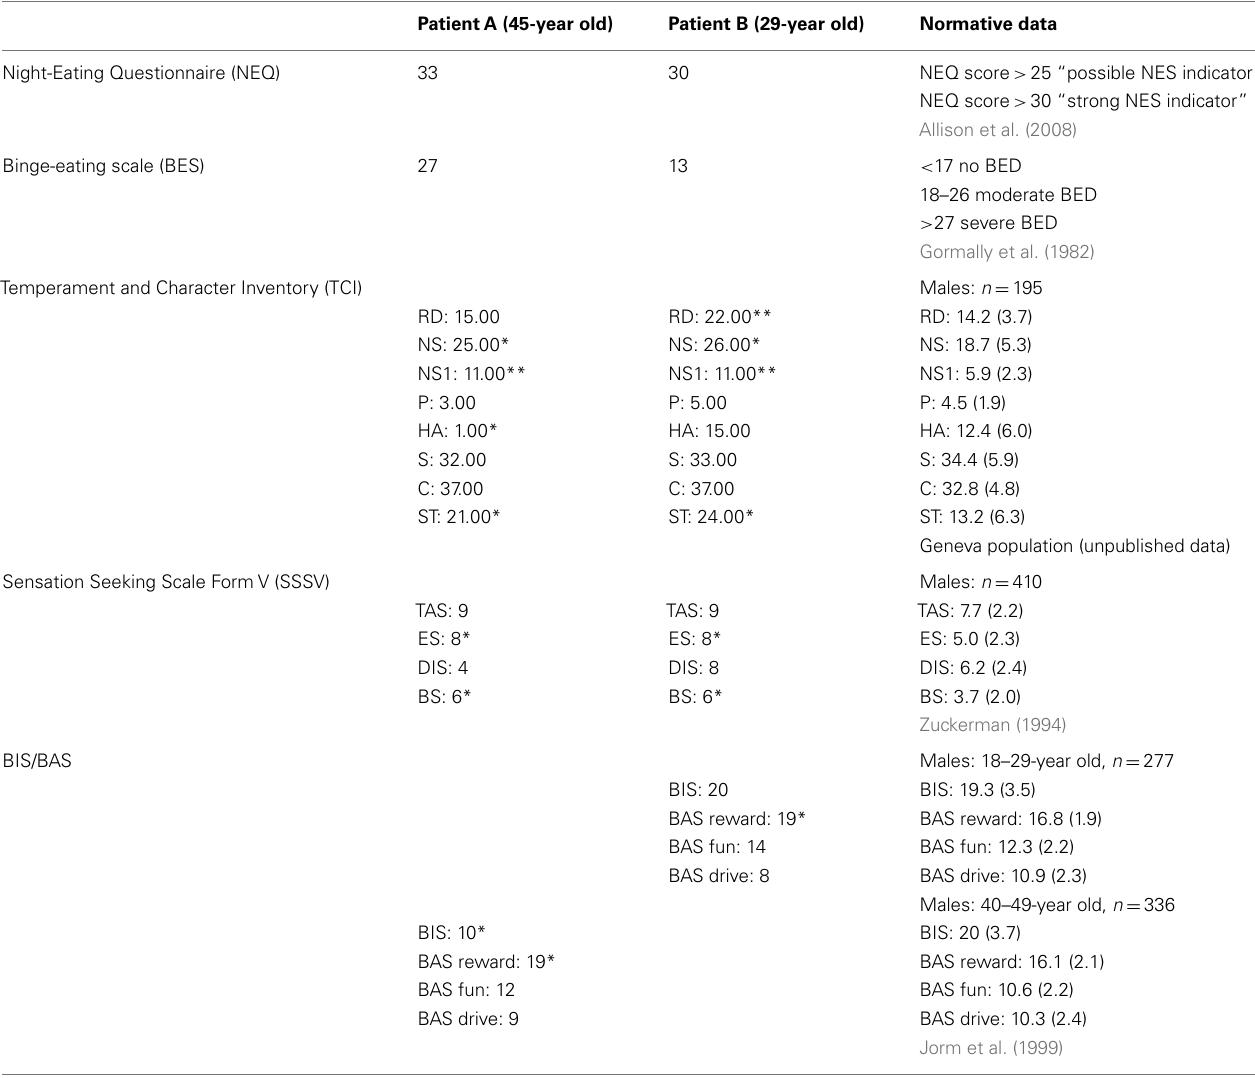
Table 2 |Assessment of patient scores ( p ) in eating-related and psychometric